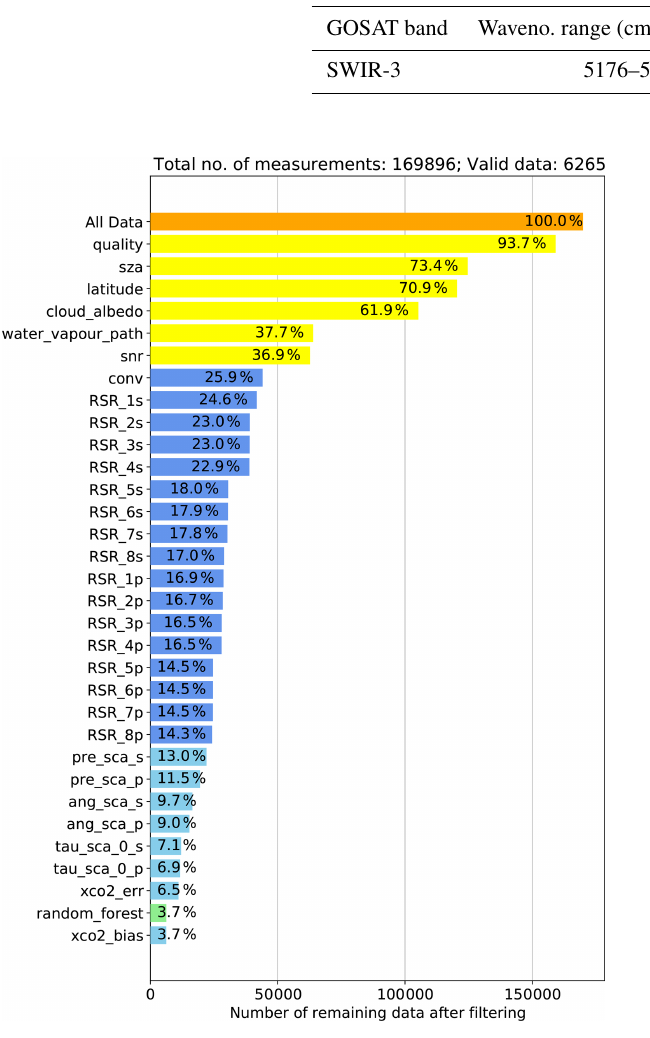
With this approximation, the FOCAL forward model is es- sentially an analytical formula; it uses pre-calculated and tabulated cross sections such that calculations can be per- formed considerably fast. The inversion of the forward model is based on optimal estimation (Rodgers, 2000) and uses the Levenberg–Marquardt–Fletcher method (Fletcher, 1971) to minimise the cost